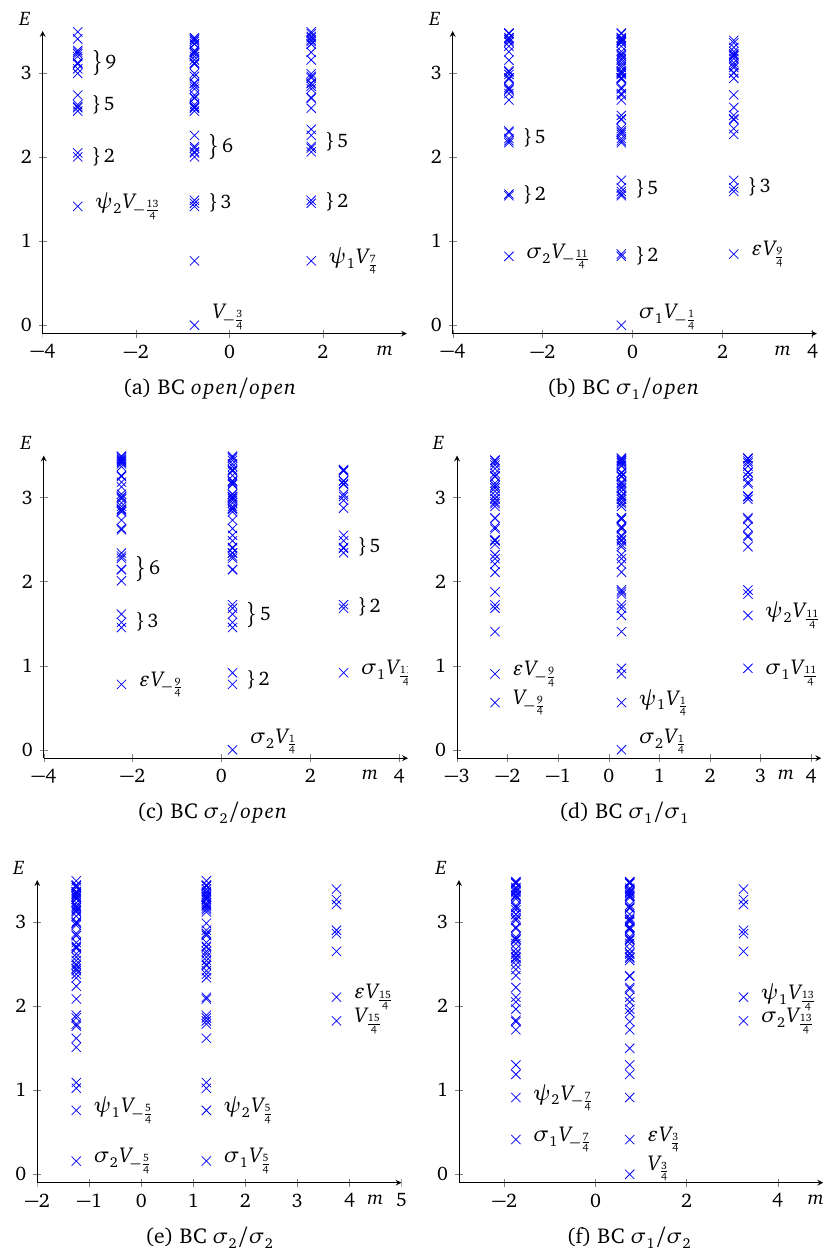
Figure 3: Numerical M model spectra with L = 25, f = 14,15,16 up to E = 3.5. The labels 3 specify the corresponding CFT